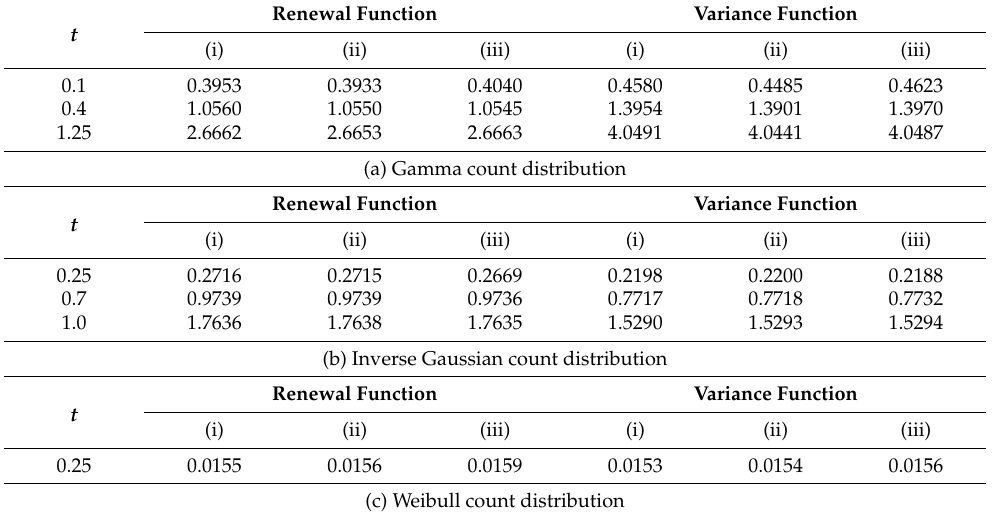
Table 5. Computation of renewal and variance functions for ( a ) gamma, ( b ) inverse Gaussian, and ( c ) Weibull count distributions for selected values of t using (i) proposed method, (ii) method of Baxter et al. (1982), and (iii) method of Chaudhry et al.